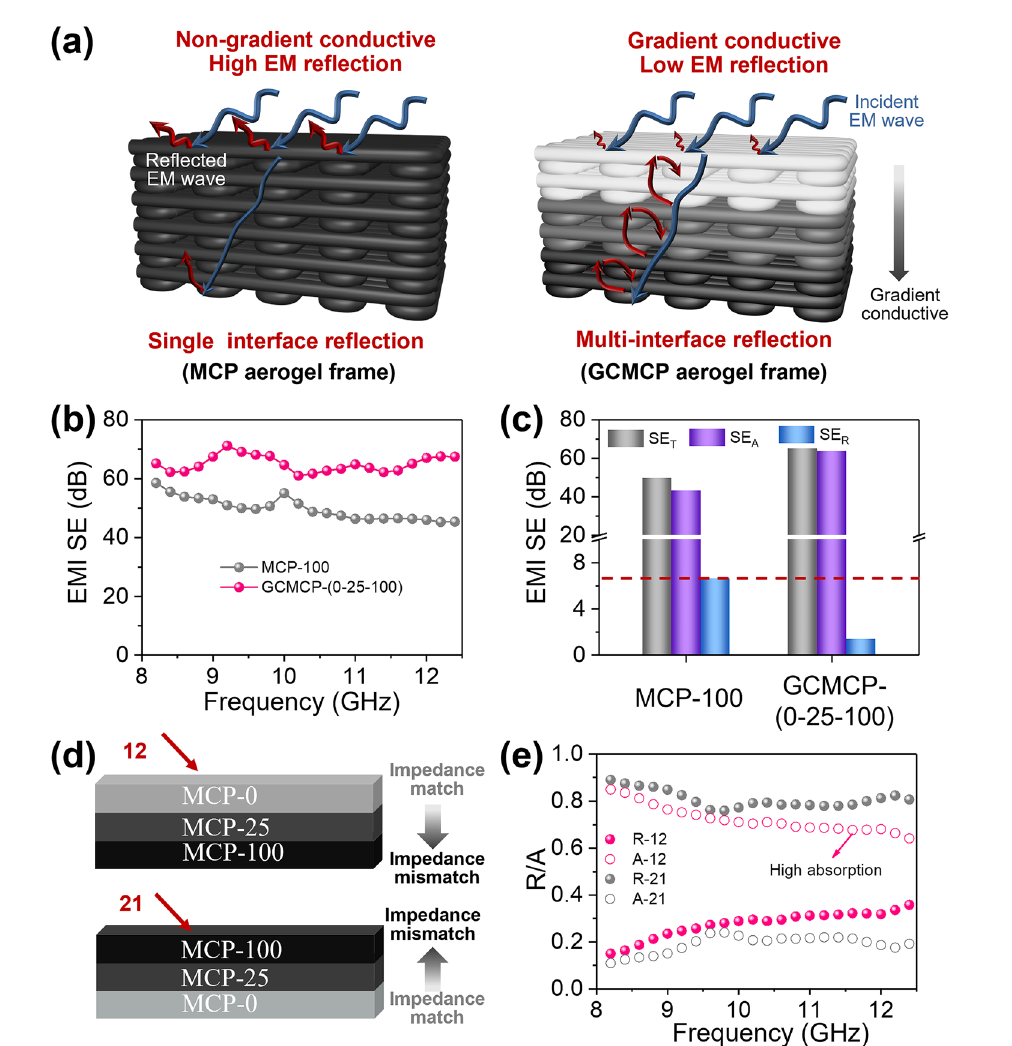
Fig. 3 Electromagnetic shielding performance of GCMCP aerogel with gradient-conductive structure at X band (thickness: about 5 mm). ( a ) Schematic representation of shielding mechanism of non-gradient conductive MCP aerogel frame and gradient-conductive GCMCP aerogel frame. ( b ) EMI shielding performances and ( c ) SE T , SE A , and SE R value of MCP-100 aerogel and GCMCP-(0–25-100) aerogel frame. ( d ) Sche- matic diagram of electromagnetic wave incident from different directions. ( e ) Reflection/absorption coefficient of GCMCP-(0–25-100) aerogel frame at different incident